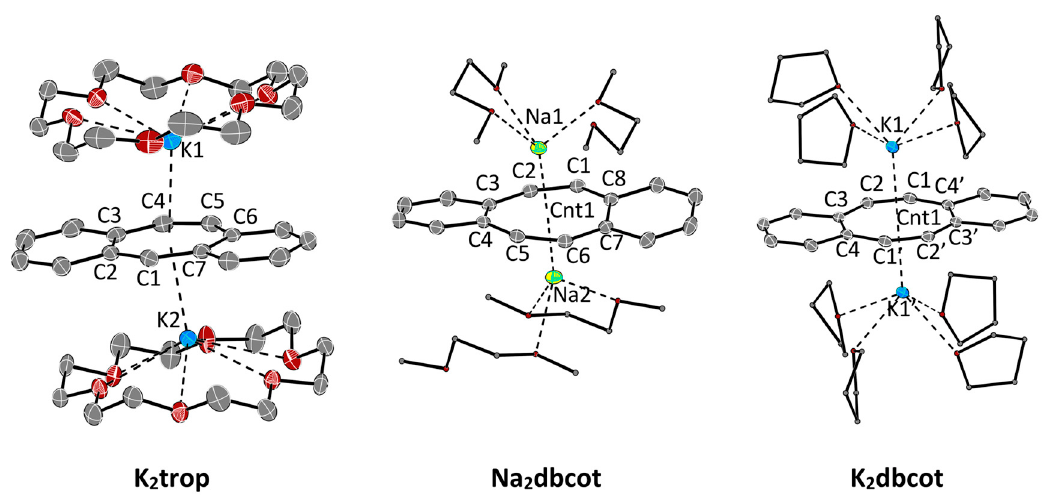
Figure 2. ORTEP plots of dianions at 50% ellipsoid probability (hydrogen atoms are omitted for clarity). K 2 trop : A co-crystallized DME-molecule is omitted for clarity. Na 2 dbot , K 2 dbot : The second chemically identical but crystallographically unique compound in the asymmetric unit is omitted for clarity. Selected bond lengths (Å) and angles ( ◦ ) are shown in Tables 3 and 4. Table 3. Data from solid-state structures (Figure 1, Figure 2, and Figure 4). For comparison, trop 2 , trop + , and Li 2 dbcot are listed as well. Abbreviations: C = C: average bond length in the central ring (Å), ∆ C = C: average bond length di ff erence in the central ring (Å), θ 1 and θ 2 : dihedral angles in the trop sca ff old ( ◦ ), ϕ 1 and ϕ 2 : dihedral angles in the dbcot sca ff old ( ◦ ), K 18c6 trop : Ktrop with